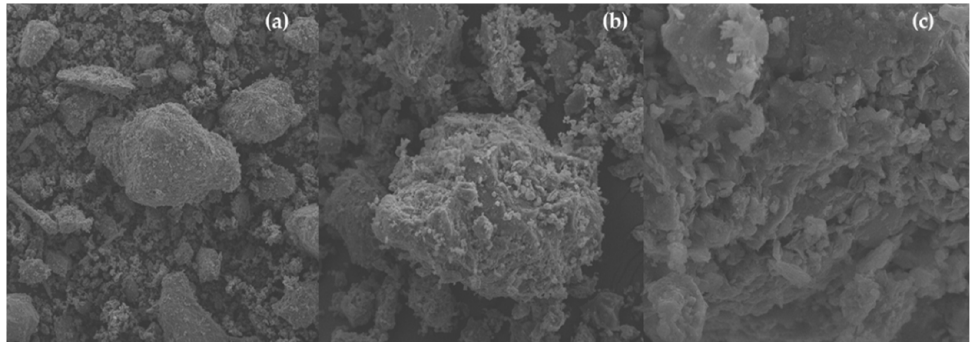
Figure 8. SEM of activated carbon pellets after catalytic upgrading of residual fat pyrolysis vapors at 400 °C, 1.0 atm, with 5.0% (wt.) activated carbon pellets impregnated with 10.0 M NaOH, in batch mode, using a semi-pilot scale reactor of 2.0 L (MAG: 838× ( a ); MAG: 3.33 k× ( b ); MAG: 6.67 k× ( c )).